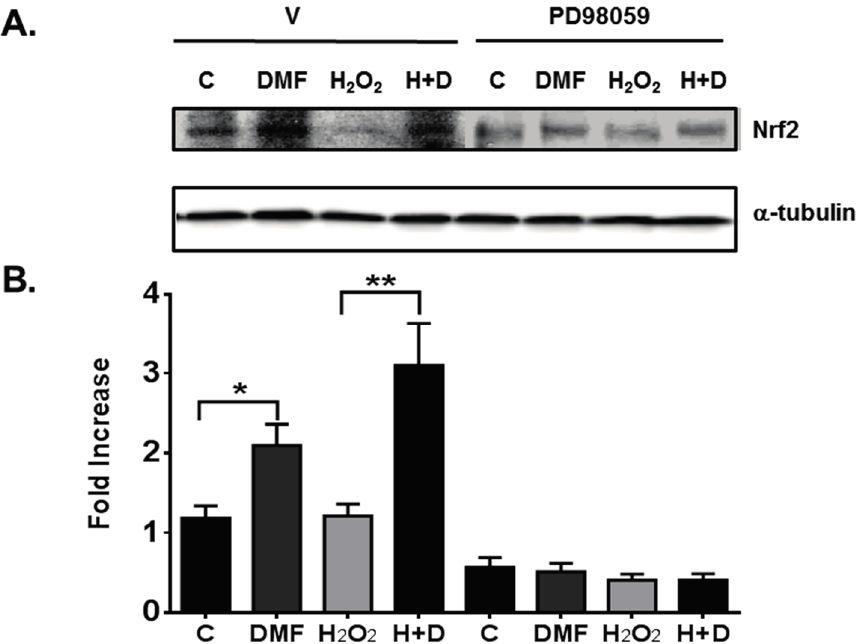
Figure 5. Effect of ERK1/2 inhibitor on Nrf2 protein level. ( A ) Whole cell lysates